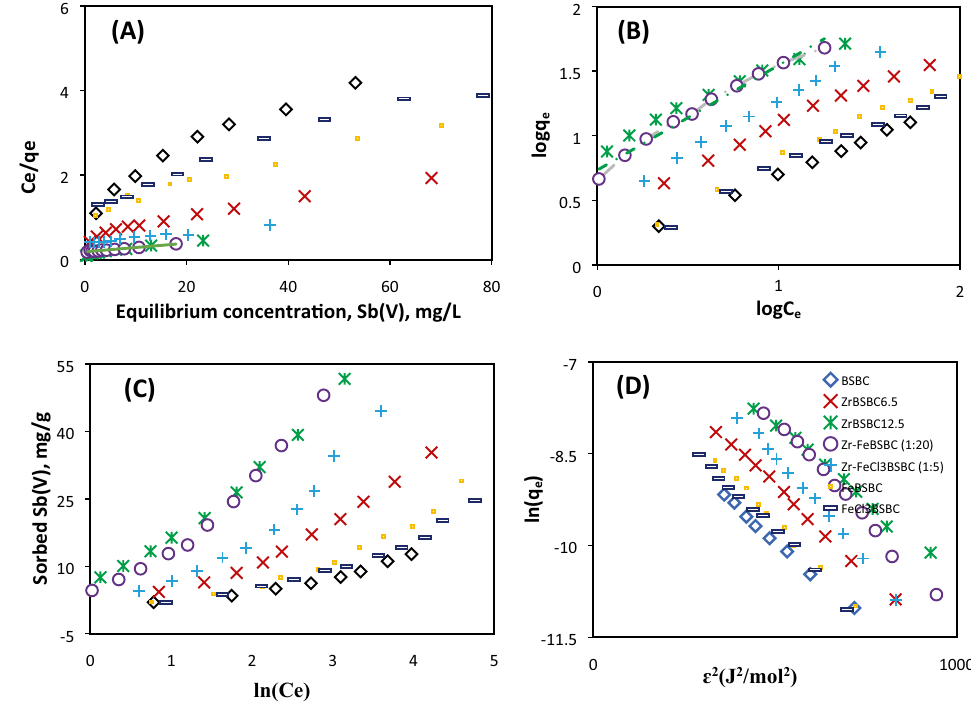
Figure 5. Isotherm model Langmuir ( A ), Freundlich ( B ), Temkin ( C ), and D–R ( D ) (Initial Sb(V) concentration was 5–250 mg/L, biochar density was 4 g/L at 22